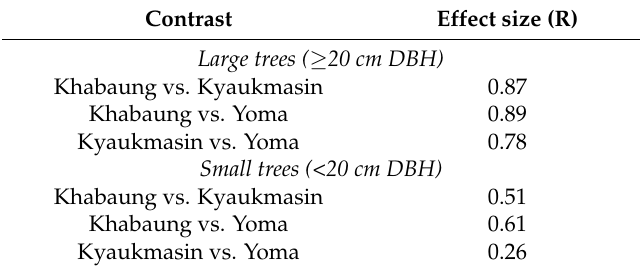
Table 3. ANOSIM (analysis of similarities) results for both the large-tree and small-tree data sets. The value of R represents the magnitude of the difference between contrasted sites. R ranges between approximately 0 and 1, where 1 represents complete dissimilarity between